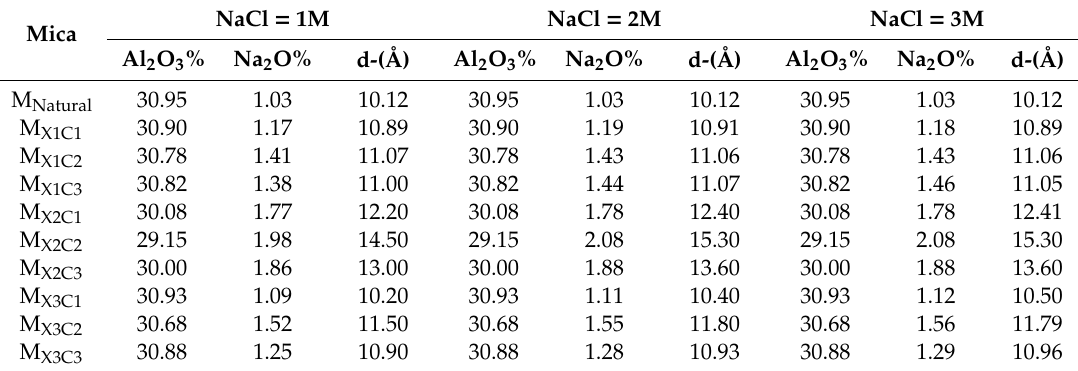
Table 3. Elemental analysis of mica samples with Na + ion exchange and changes in d-expansion values by XRD analysis. NaCl = Mica